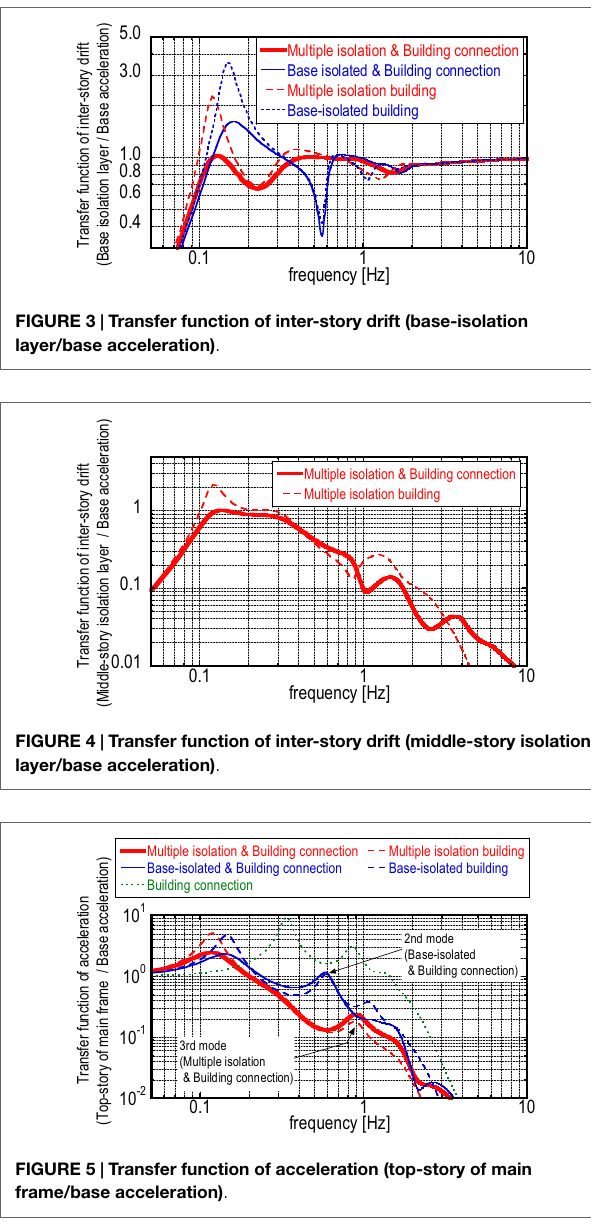
isolation and building connection model), the base-isolated